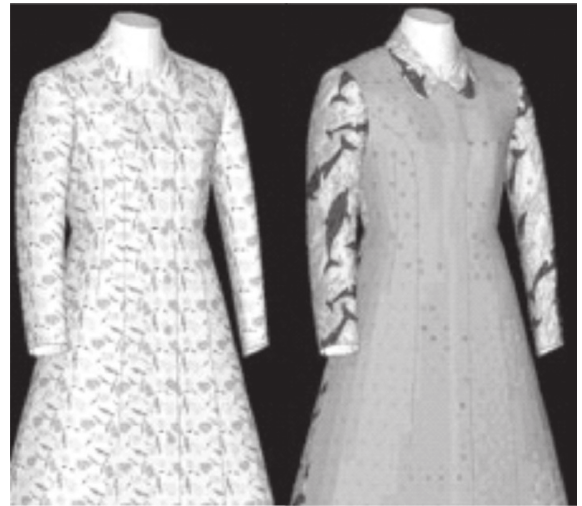
Figure 13: Virtual reality model for surplus fabric removal and reuse based on the transformation of nonsegmented